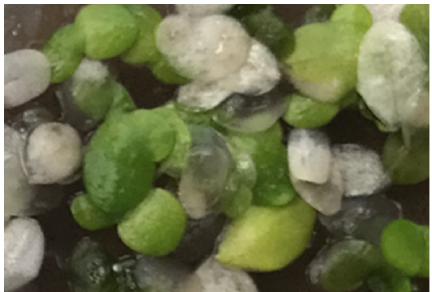
Figure 7. Naturally-aged white duckweed with younger green ones in a patch. Ho composed several aquatic poems with duckweed imagery. For example, “On the Pond” begins with two couplets featuring duckweed, as brought by Bryant [13] “Reeds grow at the mouth of a wintry pond; Daily mated to the floating duckweed .